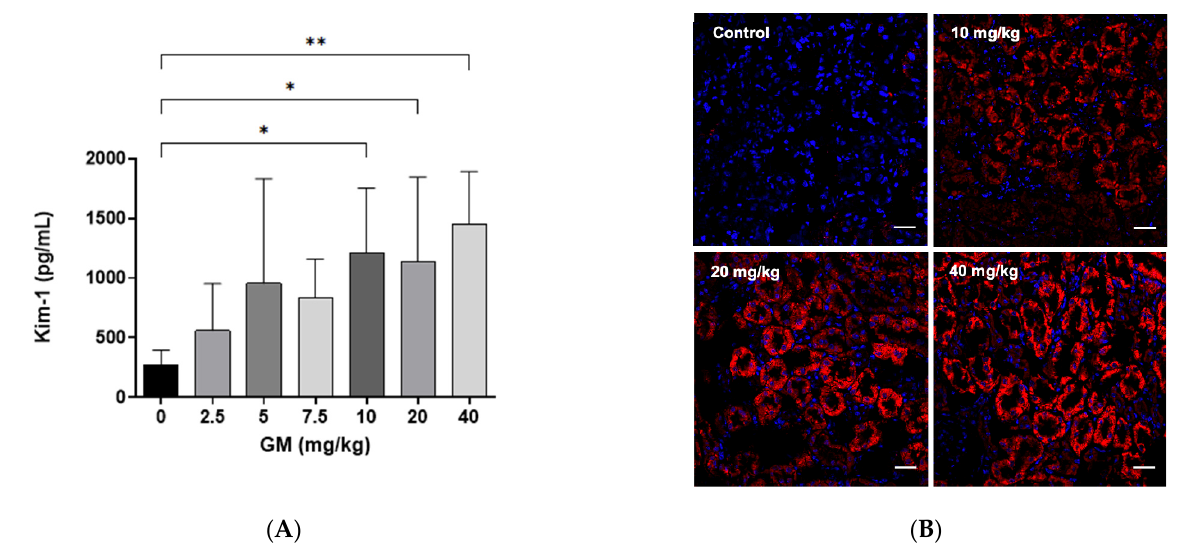
Figure 2. Kim-1 protein increases after GM administration for 7 days. ( A ) Quantification of Kim-1 protein in whole renal tissue using xMAP technology. Bar graph shows means ± SD. n = 5 animals per dose. One-way ANOVA was performed p = 0.0071. Post-hoc: Dunn test. * p < 0.05; ** p < 0.005.; ( B ) Representative micrographs of the expression pattern of Kim-1 protein (red fluorescence) in renal tissue after the exposure to 10, 20 and 40 mg of GM/kg/day. The nuclei were stained with 4,6-diamino-2-phenylindole (DAPI, blue). Scale bars represent 50 µm.